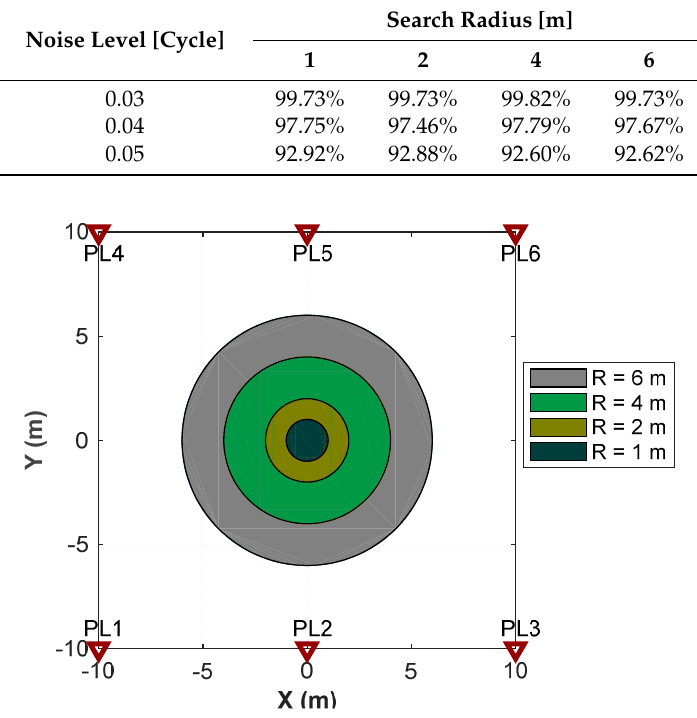
Figure 7. Illustration of the search regions with different radius.